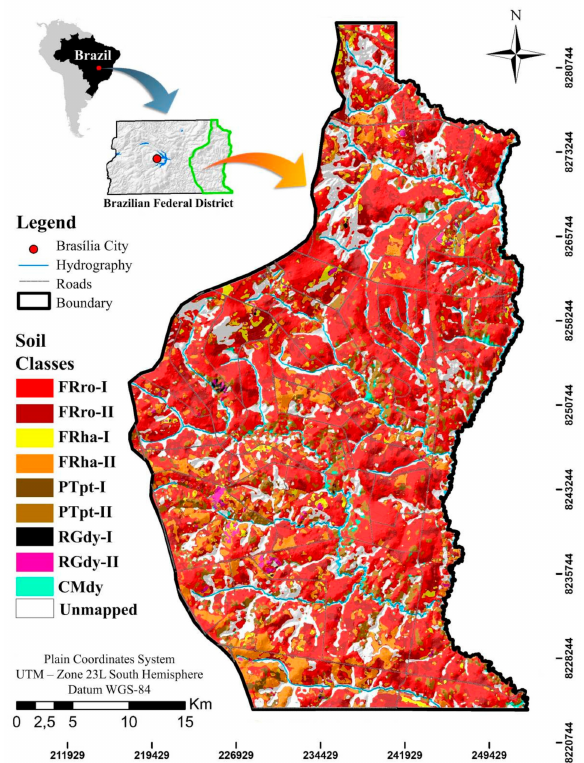
Figure 9. Digital soil map of the eastern Federal District, according to the World Reference Base [24]. FRro-I: Dystric Rhodic Ferralsol (clayic); FRro-II: Dystric Rhodic Ferralsol (very clayic); FRha-I: Dystric Haplic Ferralsol (clayic); FRha-II: Dystric Haplic Ferralsol (loam-clayic); PTpt-I: Dystric Petric Plinthosol (clayic); PTpt-II: Dystric, Petric Plinthosol (very clayic); RGdy-I: Dystric Regosol (very clayic); RGdy-II: Dystric Regosol (very clayic); and CMdy: Dystric Haplic Cambisol